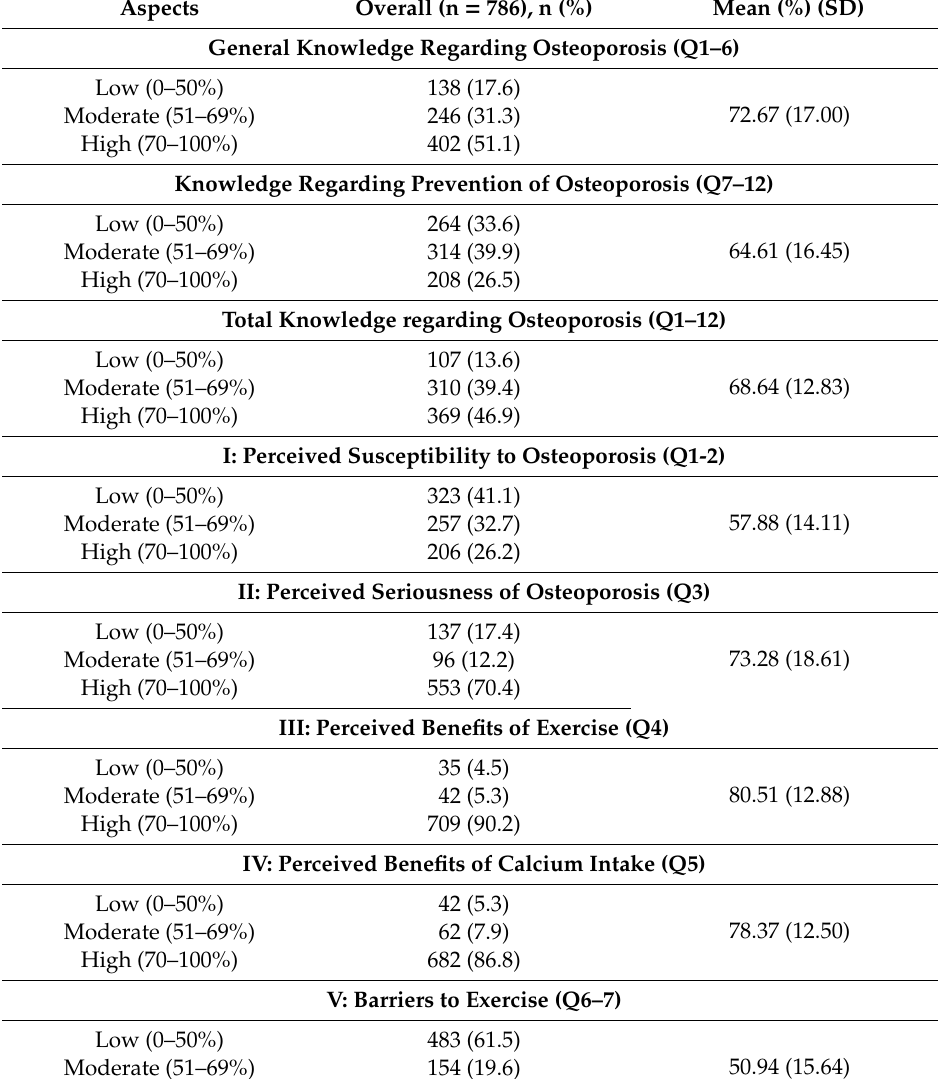
Table 2. Level of knowledge and beliefs towards